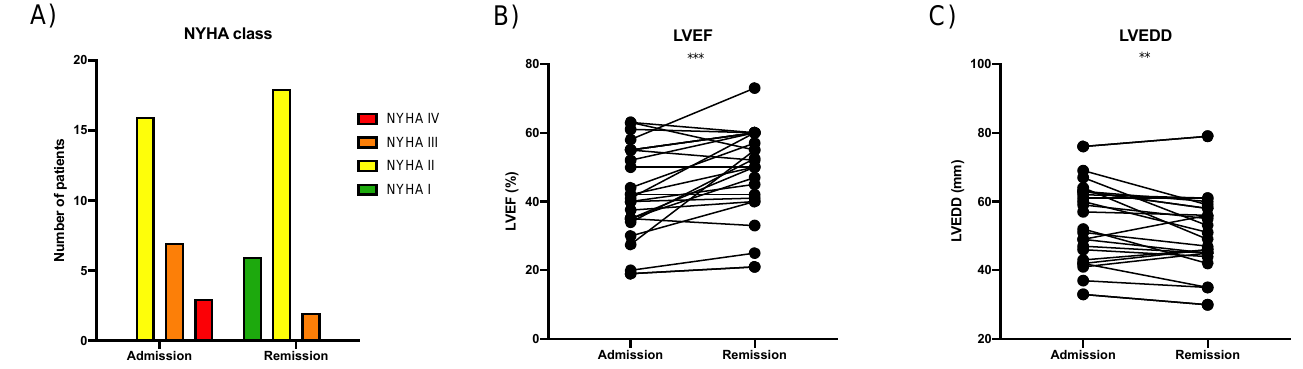
Figure 3. Patients with HHV6 DNA-associated myocarditis may improve spontaneously. ( A ) Columns represent the New York Heart Association (NYHA) functional class distribution of the patients at admission and after spontaneous remission. Connected dots represent the individual changes in ( B ) left ventricular ejection fraction (LVEF), ( C ) LV-end-diastolic diameter (LVEDD) be- tween admission and spontaneous remission, N = 26. Statistically tested via paired t -test, ** p ≤ 0.01, *** p ≤ 0.001.